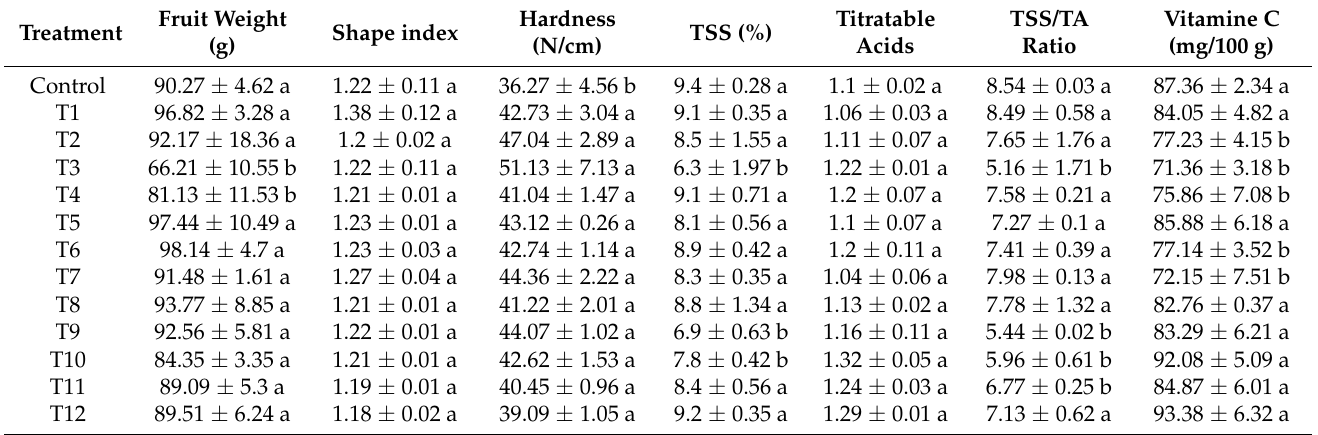
Table 1. The effect of different treatments on fruit quality during kiwifruit ( Actinidia chinensis ) ‘Donghong’